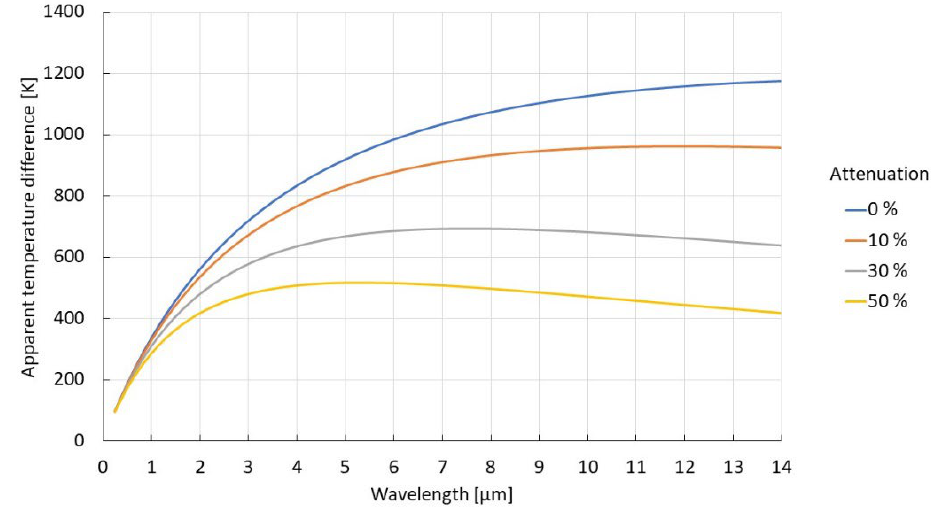
Figure 3. The effect of attenuation along the line of sight on the apparent temperature difference for two objects of different emissivities ( ε 1 = 0.9 and ε 2 = 0.2) and the same true surface temperature of 2000